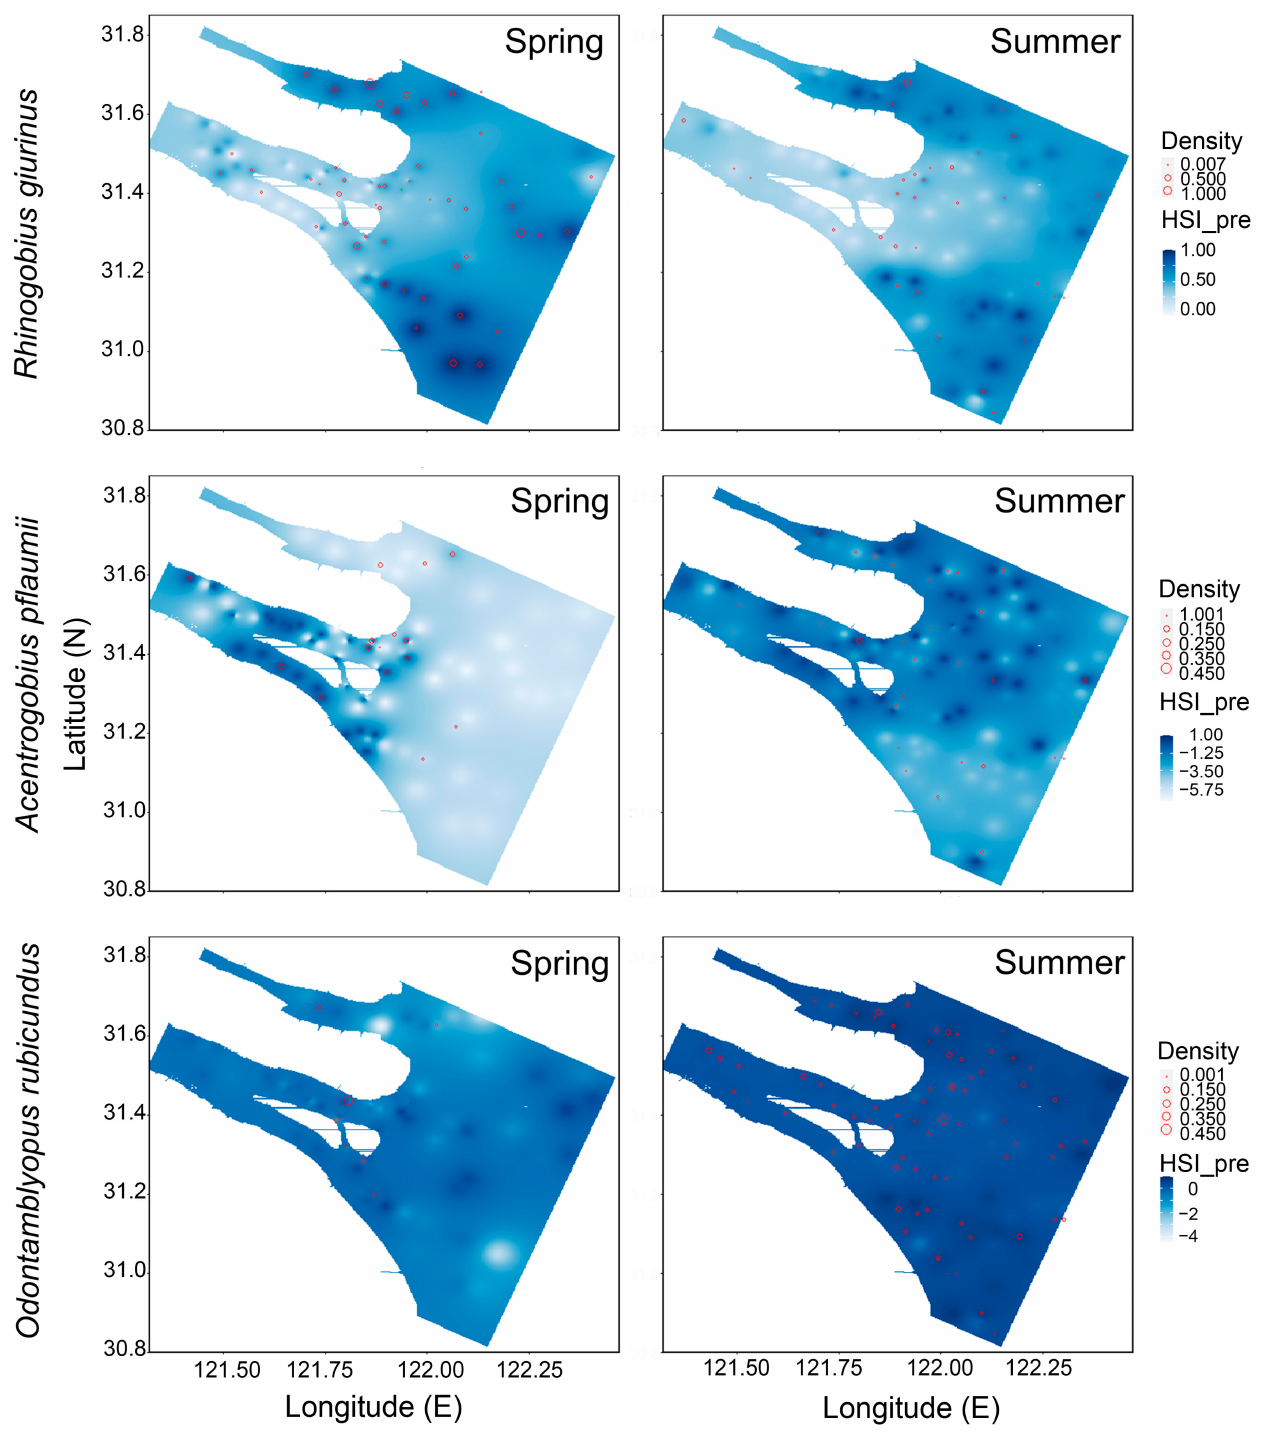
Figure 5. The distributions of HSI gini and the surveyed density of larval gobies in the Yangtze Estuary in spring and